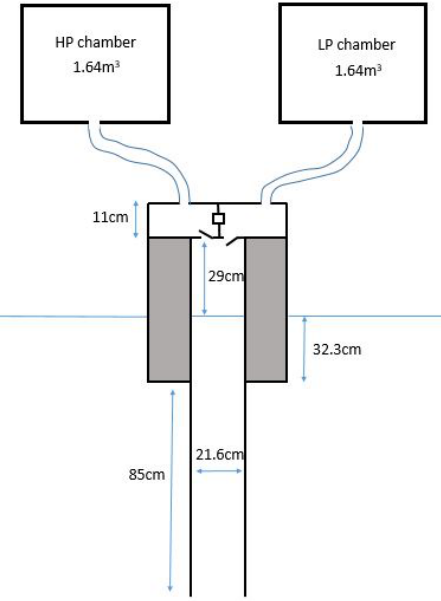
Figure 2. Schematic of the model scale conventional Oscillating Water Column (OWC) and Tupperwave